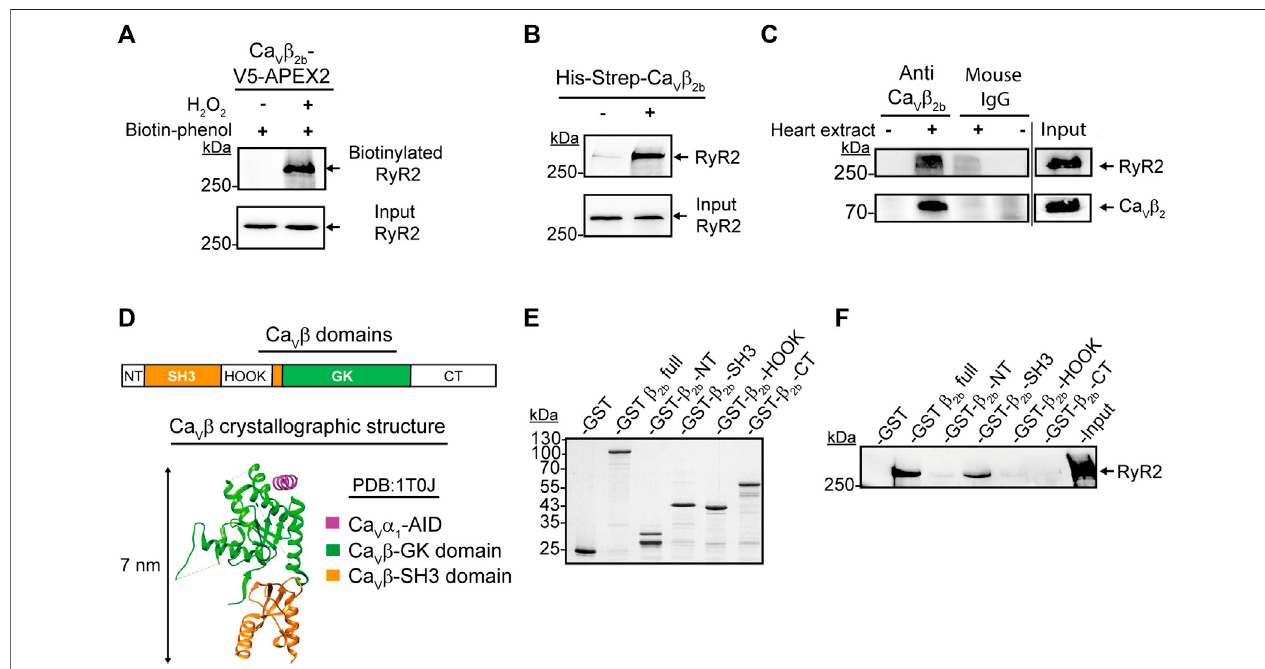
FIGURE3 | Interaction between Ca v β 2b and the RyR2. (A) Biotinylationof the RyR2 byCa v β 2b -V5-APEX2. Western blotanalysisusing an anti-RyR2 antibody after streptavidin-mediatedenrichmentofbiotinylatedproteins. (B) Pull-downassayoftheRyR2withtherecombinantHis-Strep-Ca v β 2b .Mouseheartlysateswereincubated with Strep-Tactin ® -coated beads with or without the puri fi ed His-Strep-Ca v β 2b and the eluates were analyzed by western blot using an anti-RyR2 antibody. (C) Co- immunoprecipitation of the RyR2 with Ca v β 2b from mouse heart lysates. Ca v β 2b was immunoprecipitated using an anti-Ca v β 2b antibody and the co-precipitated RyR2 was analyzed by western blot. Normal mouse IgG was used as negative control. The upper and lower panels show a western blot using anti-RyR2 and a commercial anti-Ca v β 2 antibodies, respectively. (D) Schematic diagram of Ca v β 2b domains: NT (N-terminus), SH3 (Src-homology 3 domain), HOOK, GK (guanylate kinasedomain),CT(C-terminus)(i)andcrystalstructure(PDB:1T0J)(vanPetegemetal.,2004)oftheCa v β inacomplexwiththeAIDofCa v α 1 (magenta),Ca v β -GK(green) andCa v β -SH3(orange)domains(ii)areshown. (E) Coomassieblue-stainedSDS-PAGEgelwiththepuri fi edrecombinantproteinsusedinpanelf(1 μ gperlane). (F) Pull- down assay of the RyR2 with the puri fi ed recombinant Ca v β 2b domain proteins. Strep-Tactin ® -coated beads coupled to the puri fi ed recombinant proteins were incubated with mouse heart lysates and the eluates were analyzed by western blot using an anti-RyR2 antibody. The GST and Ca v β 2 full protein were used as negative and positive controls, respectively. All the data shown are representative of three independent experiments. AID, alpha interaction domain; RyR2, ryanodine receptor 2.